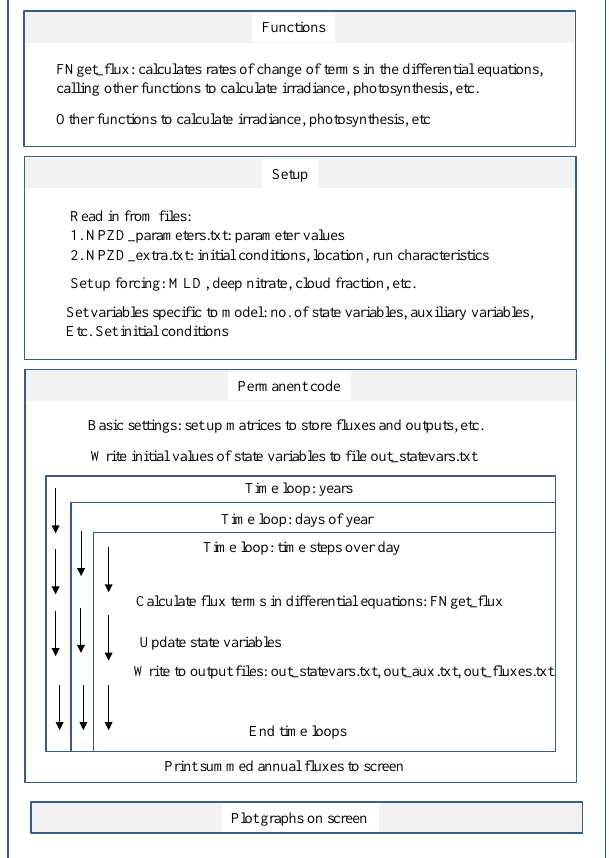
Figure 8. Structure of the model